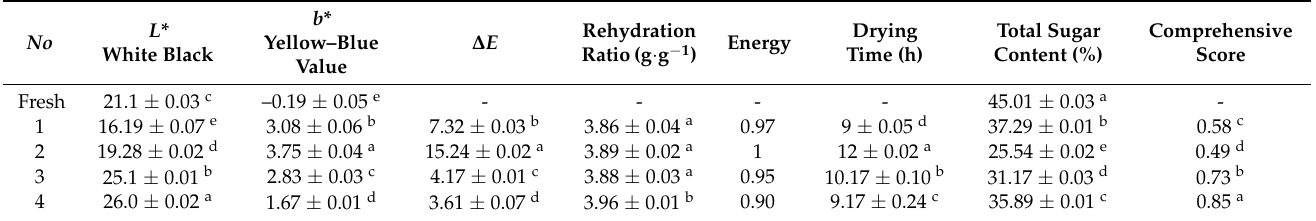
Table 3. Color values, rehydration ratios, energy consumptions, drying times, total sugar contents, and comprehensive scores under different drying conditions.